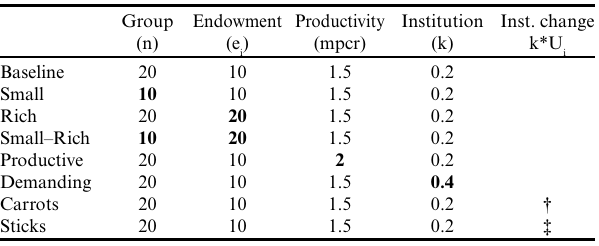
1. Treatment variations regarding